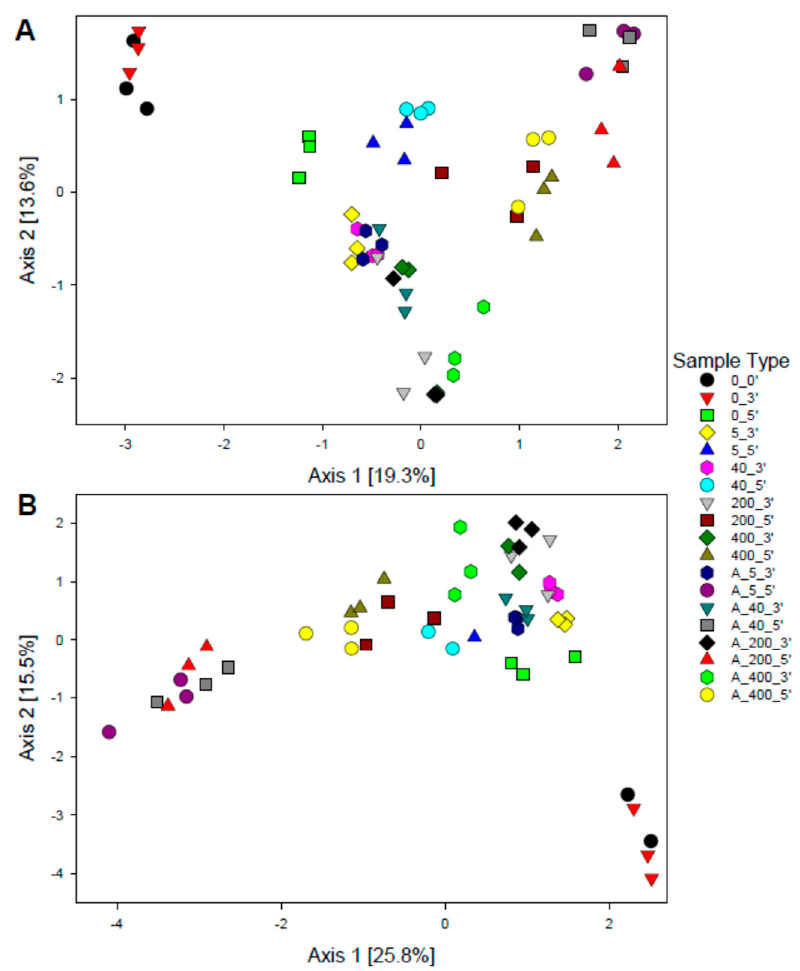
Figure 2. Principal coordinate analysis of the Bray–Curtis dissimilarity metric showing the effect of ibuprofen and ibuprofen/acetate treatments on the bacterial community composition based on OTUs from the 16S rRNA gene (panel A ) and 16S rRNA (panel B ). Sample code: A, amended with 1 mM acetate and ibuprofen per feeding; 0, 5, 40, 200, and 400 indicate supplemental ibuprofen concentrations of 0, 5, 40, 200, and 400 µM, respectively, given per feeding; 0 ′ , 3 ′ , and 5 ′ , correspond to samples obtained at the start of the incubation, and after the third and fifth refeeding, respectively. Sampling times for unamended controls were according to those of the 400 µM ibuprofen treatment.